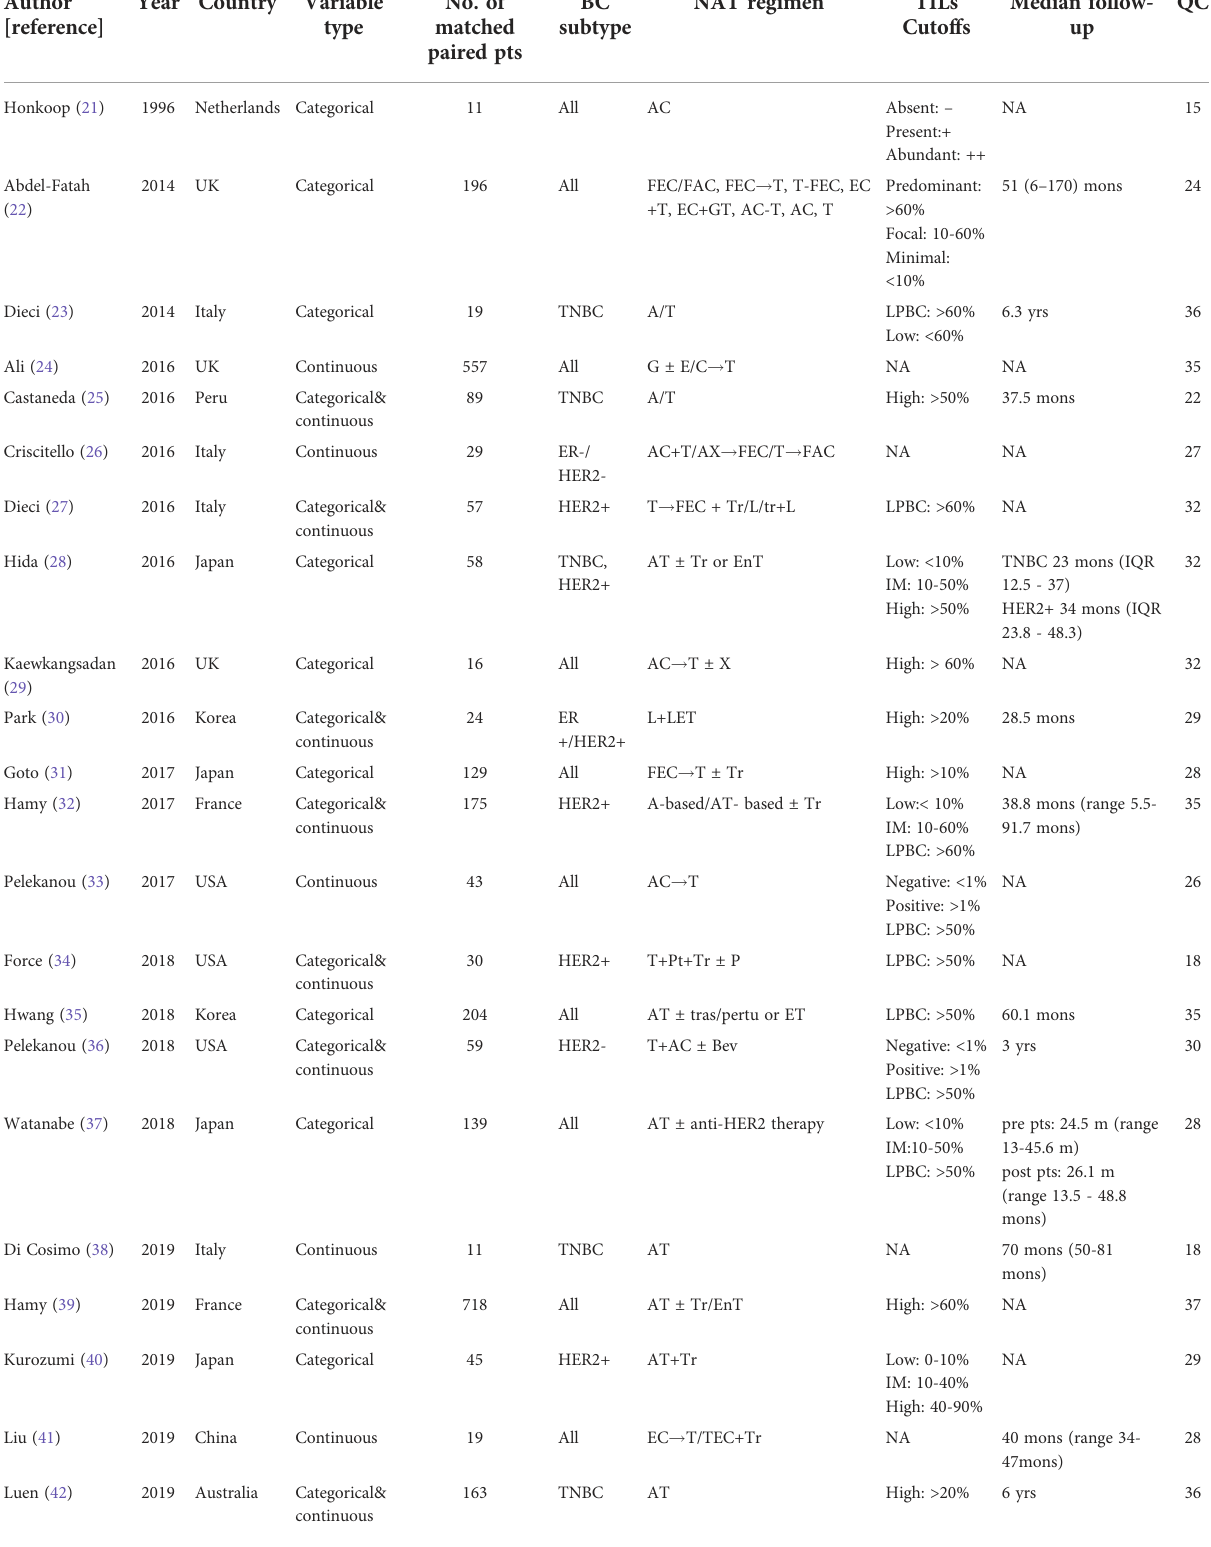
TABLE 1 Characteristics of studies included in the